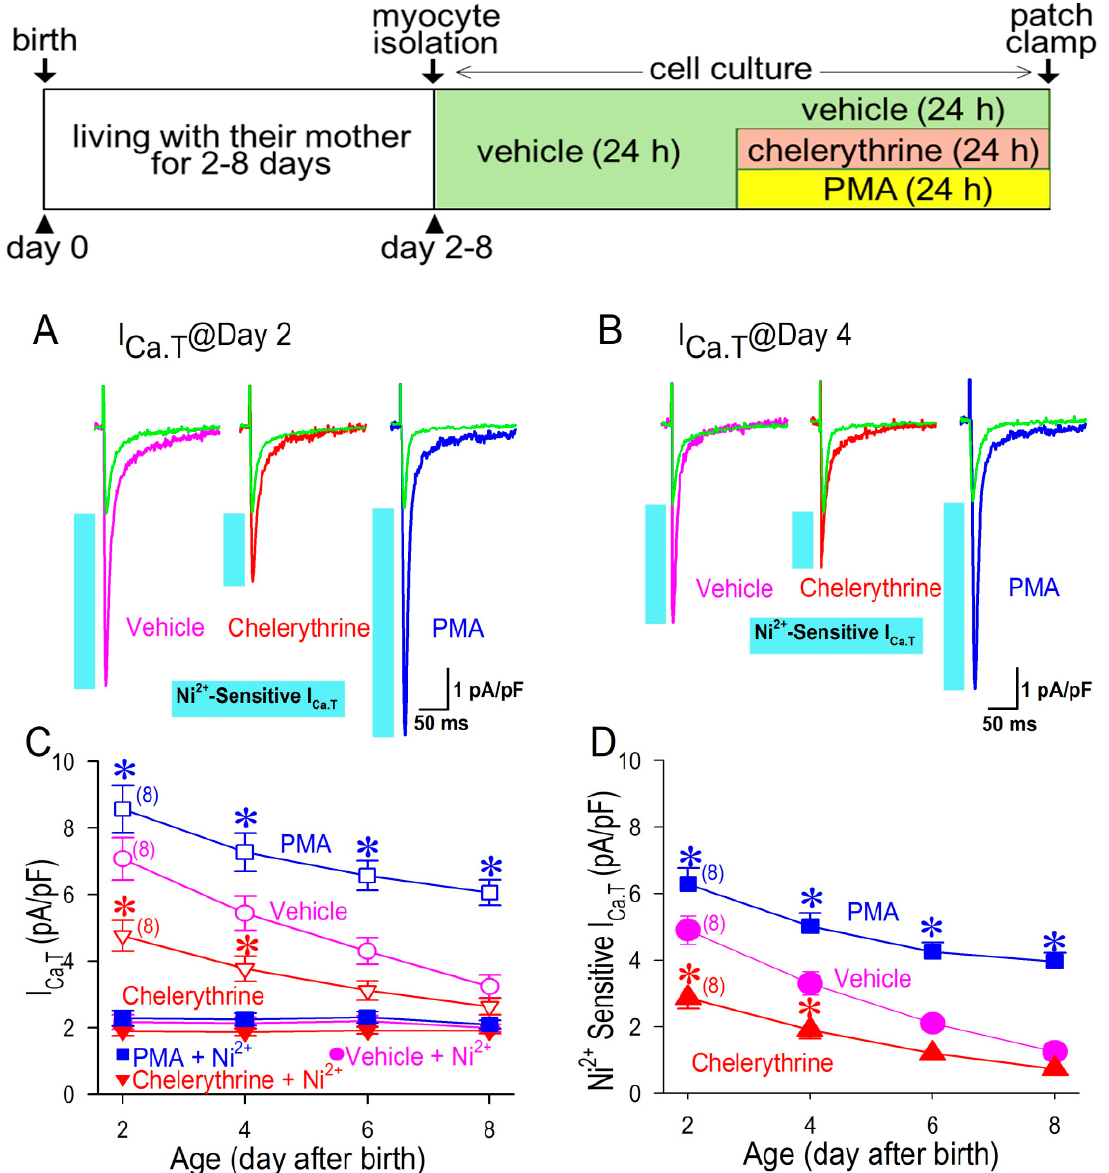
Figure 4. Time-dependent changes of I Ca.T . Representative I Ca.T with or without 50 µ M Ni 2+ in myocytes isolated at day 2 ( A ) and day 4 ( B ) after birth, treated in vehicle, 2 µ M chelerythrine, or 1 µ M PMA. I Ca.T was recorded at the test potential of 0 mV with or without Ni 2+ application for 5 min in the same patch. Blue bars represent a current component caused by Ni 2+ or Ni 2+ -sensitive I Ca.T . ( C ) Time-dependent changes of I Ca.T with or without Ni 2+ were plotted against day after birth from day 2 to day 8 treated in vehicle, 2 µ M chelerythrine, or 1 µ M PMA. ( D ) Time-dependent changes of Ni 2+ -sensitive I Ca.T . Note that chelerythrine and PMA were washed out in the culture medium prior to the electrophysiological study. Data were expressed as mean ± S.D. ( n = 8). * p < 0.05, compared with those in vehicle at the same age. Protocols for myocytes isolation and cell culture are shown in the inset